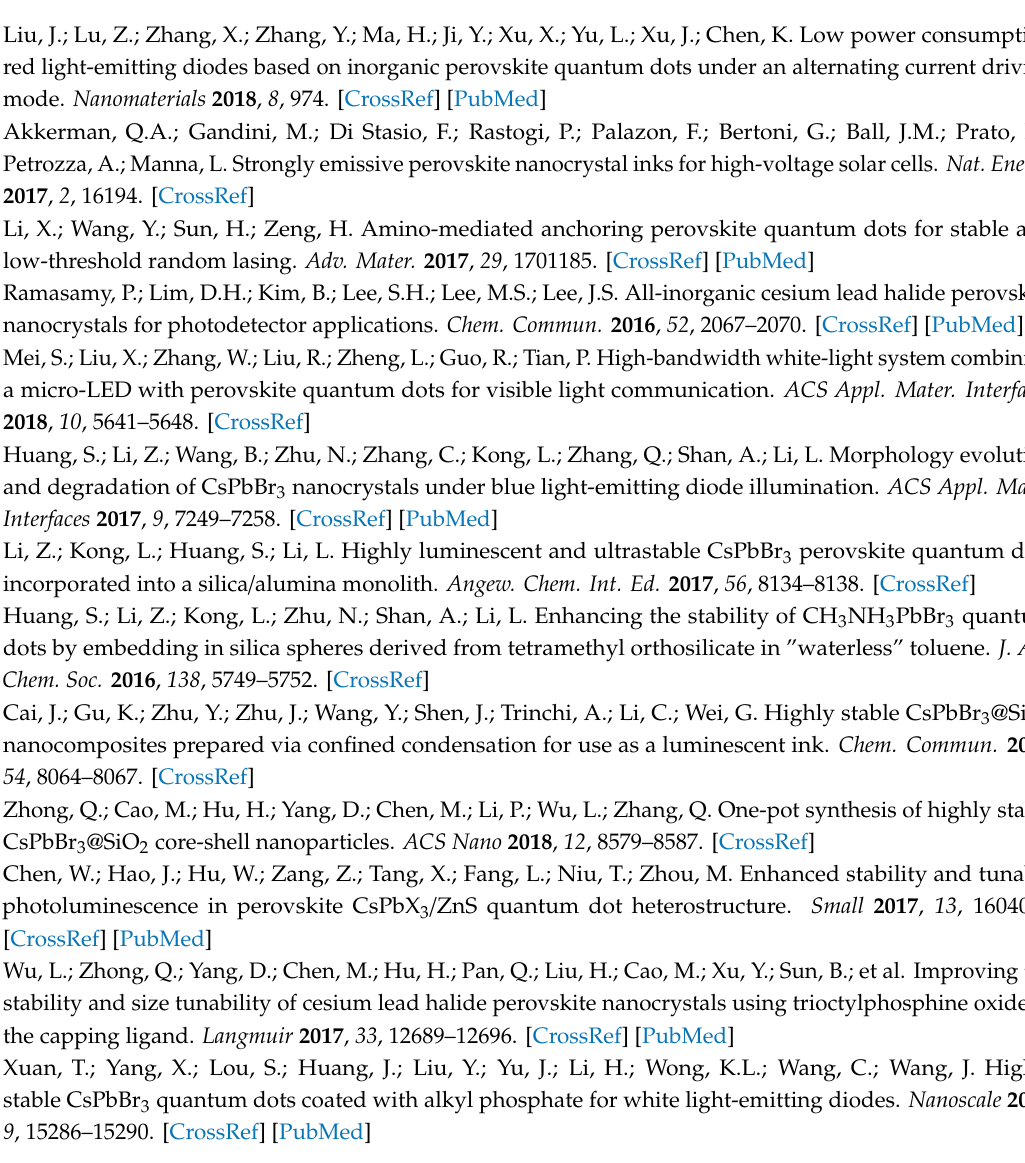
Figure S1: (a) XPS spectra of CsPbBr 3 and CsPbBr 3 / ZIF-8 composite and binding energy spectra of (b) Zn 2p, (c) Cs 3d, (d) Pb 4f, and (e) Br 3d for the comparison, Table S1: The atomic ratio of each component in CsPbBr 3 and CsPbBr 3 / ZIF-8, Table S2: Relevant Parameters of the synthesized CsPbX 3 and CsPbX 3 / ZIF-8 powders, Figure S2: (a) photostability, (b) thermal stability, (c) moisture resistance and (d) long-term storage stability test of CsPbBr 3 QDs and CsPbBr 3 / ZIF-8 composites, Figure S3: Schematic representation of the preparation process of CsPbBr 3 / ZIF-8@PMMA